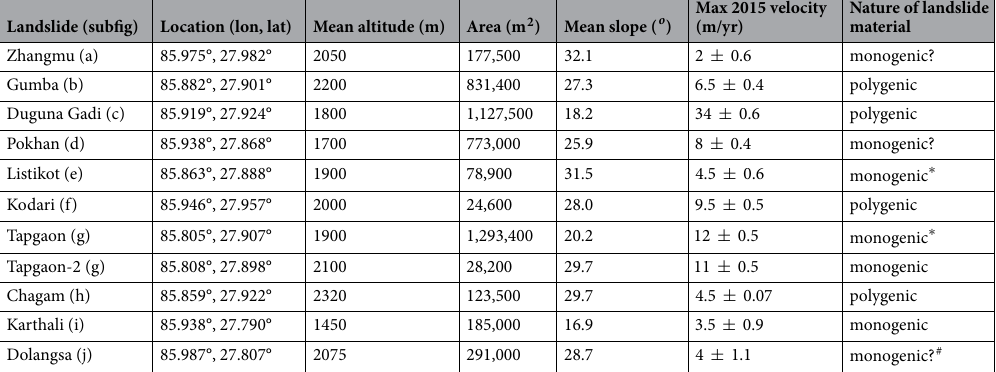
Table 1. Detected landslide characteristics (see their locations on Fig. 2 and the zooms on Fig. S3). polygenic = landslides and rockfall debris accumulation. monogenic = lower part of a former hillslope collapse (i.e. fragmented and weathered bedrock). ?= not visited on the field (the origin of the material is only estimated ∗ from topographic settings observed on Google Earth). = probable limited displacements (slope of the slided # mass not very different from the regional hillslope gradient). = probable large displacements (slope of the slided mass much shallower than the regional hillslope